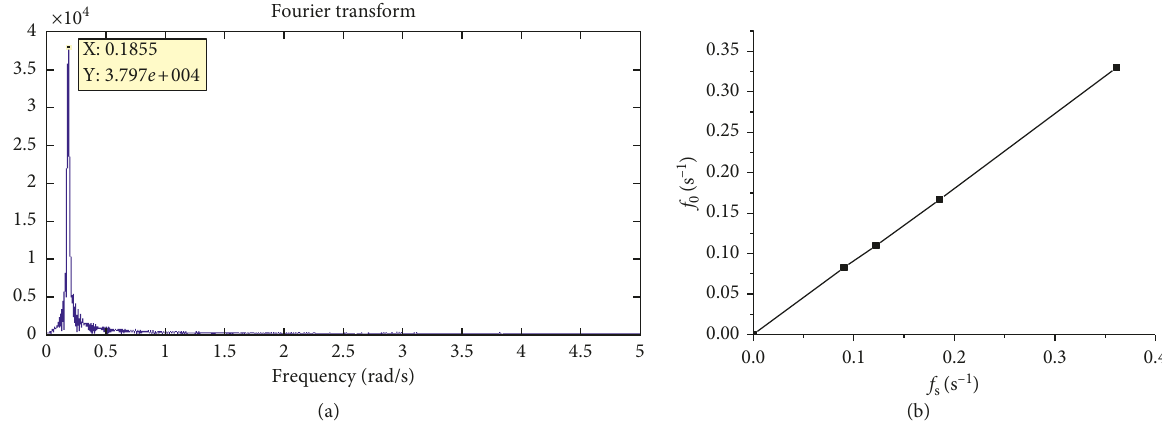
Figure 2: Discrete validation between theoretical and experimental oscillatory flow (a) FFT for y